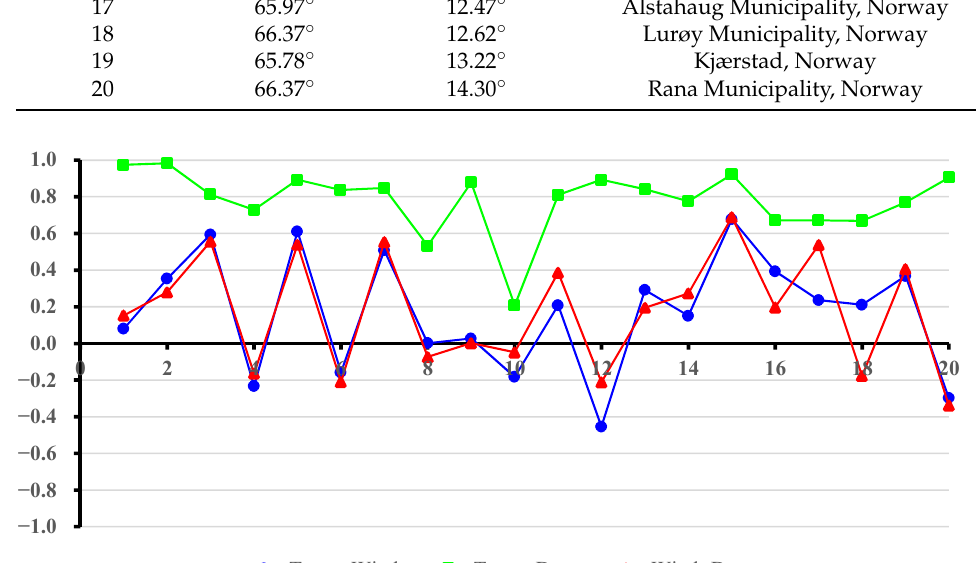
Figure 8. Zero-lag cross–correlations between mean temperature, wind speed, and dew point (annual Figure 8. Zero ‐ lag cross–correlations between mean temperature, wind speed, and dew point (an ‐ scale, a sample of 20 nual scale, a sample of 20 stations).